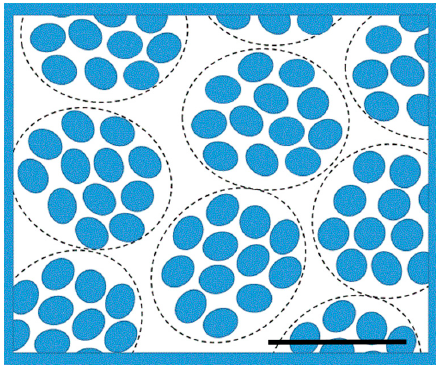
Figure 8. Schematic drawing of the shell microstructure revealed by SAXS showing individual lysozyme molecules (blue) arranged in dense lysozyme-PSS complexes of finite size. PSS network omitted for clarity. Bar = 16 nm.